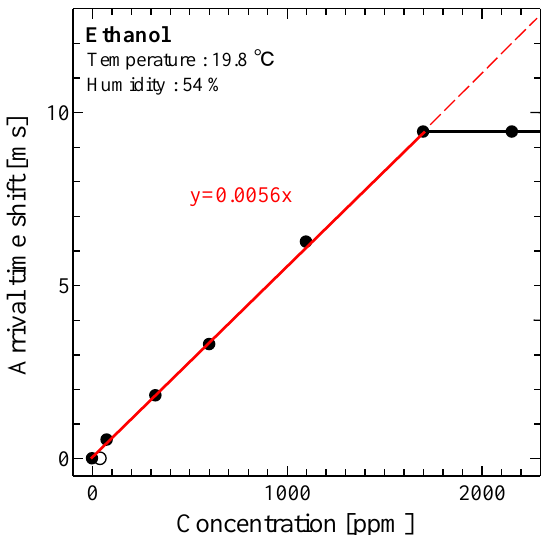
Figure 3. Relationship between concentration and arrival-time shift of ethanol. The open circle was not included in the calibration curve because 40.8 ppm is not a shift from the RIP. The measurement error of the flow rate was estimated to be ~3%.